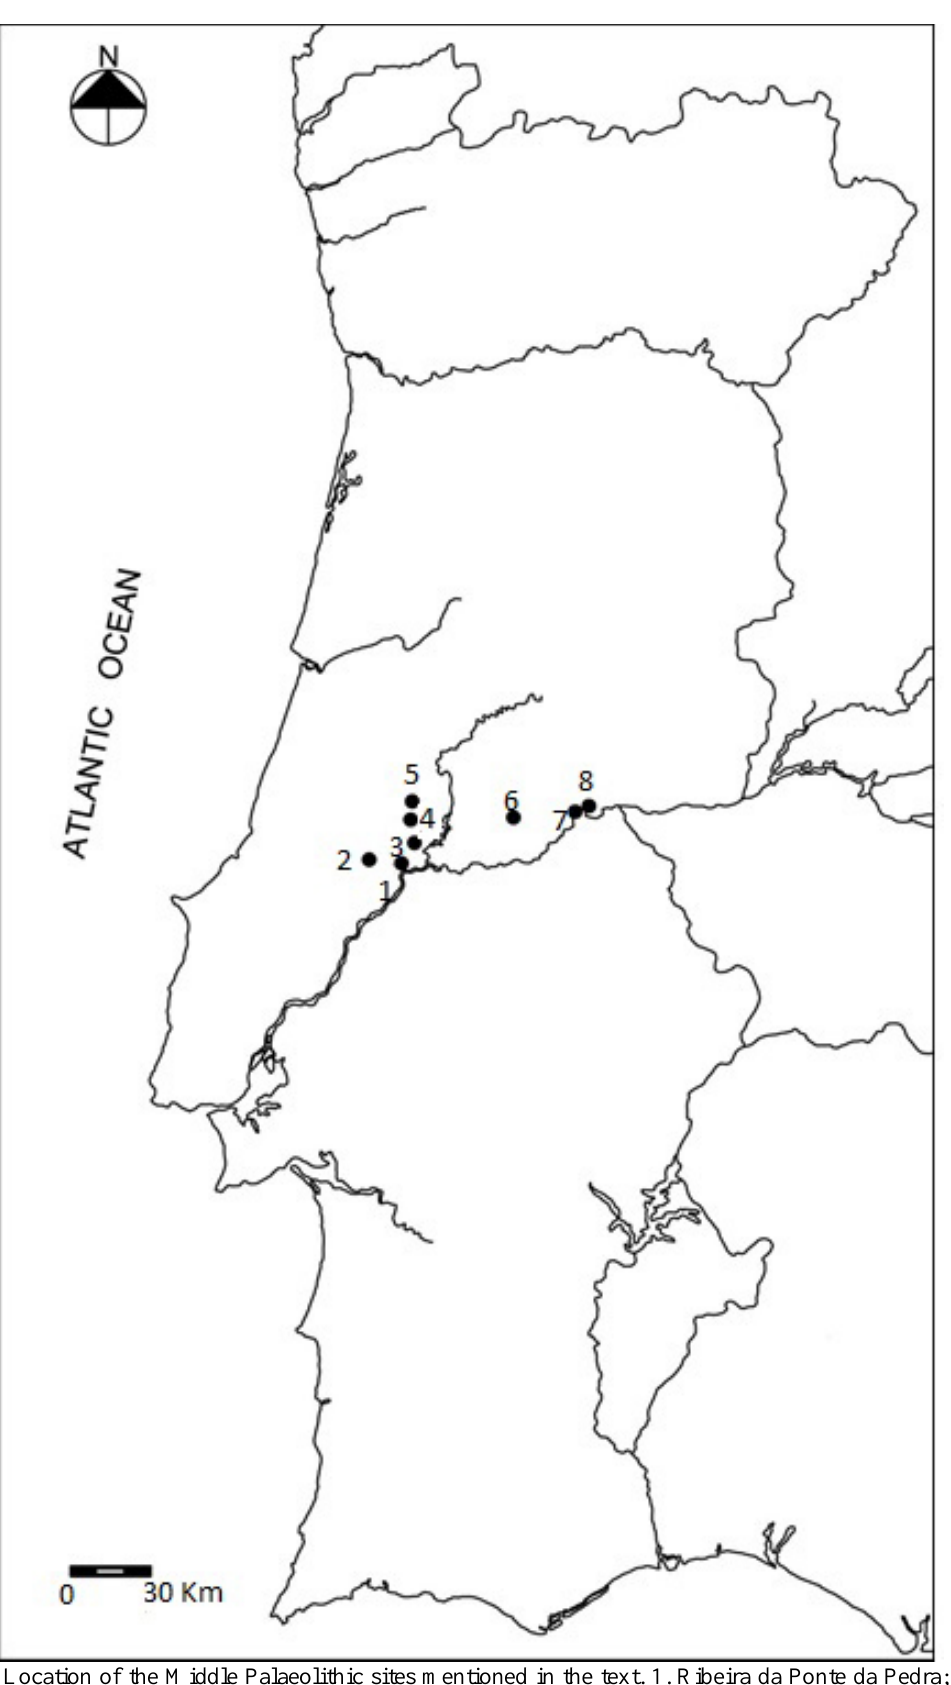
Figure 2. Location of the Middle Palaeolithic sites mentioned in the text. 1. Ribeira da Ponte da Pedra; 2. Gruta da Oliveira; 3. Santa Cita; 4. Gruta do Caldeirão; 5. Estrada do Prado; 6. Lagoa do Bando; 7. Vilas Ruivas; 8. Foz do Enxarrique (modified from Cardoso,